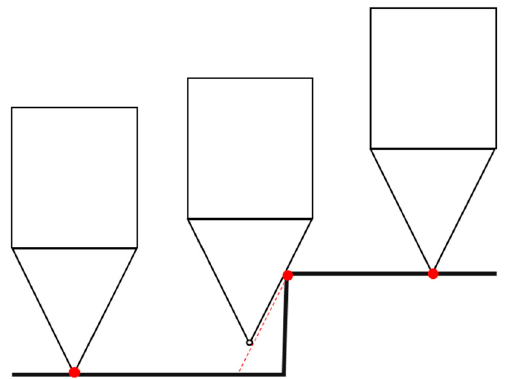
Figure 16. Effects of a finite stylus shape: the tip prevents the stylus from reaching the bottom of the step transition, the red trajectory is followed instead.